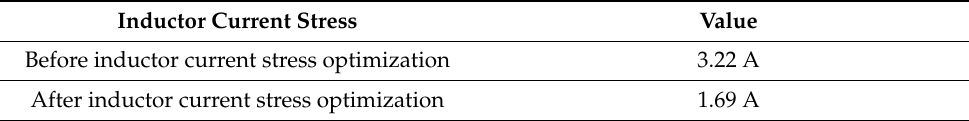
Table 5. Inductor current stress of converter.